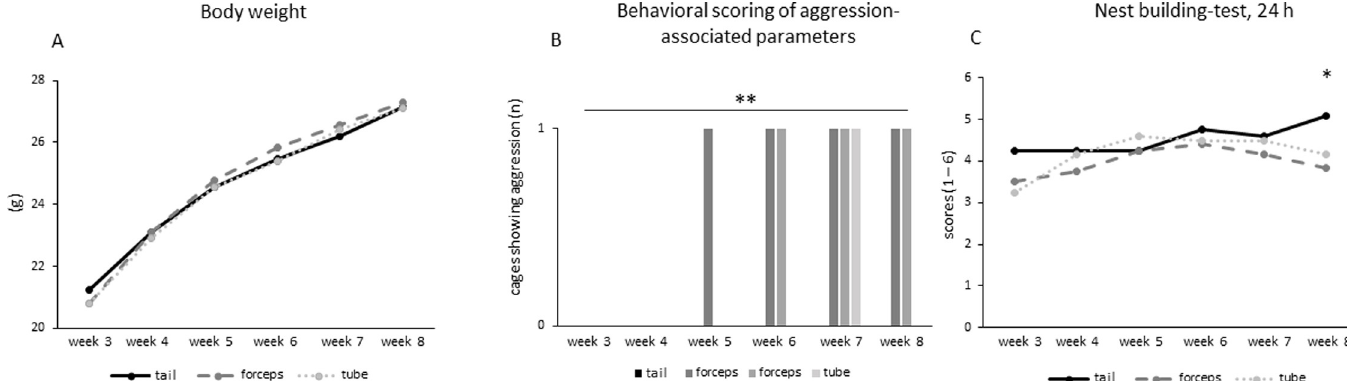
Fig 2. Development. A) Nest building test, 24 h (n of cages = 36, 24 mice/handling method). A significant overall effect (p < 0.05) revealed regarding the factor ‘handling’. Furthermore, a significant difference in the nest building performance is seen by the last week of housing and handling, indicating the role of experience. B) Behavioral scoring of aggression-associated parameters, (n = 54, 18/handling method). There was a significant overall effect concerning the number of attacks: forceps-handled group-housed mice had an increase in the number of attacks compared to the other handling methods (p < 0.01). C) Body weight, (n = 72, 24/handling method). No difference in the development was found regarding the factor ‘housing’ or ‘handling’. Asterisks indicate the level of significance ( � p � 0.05; �� p � 0.01; ��� p �